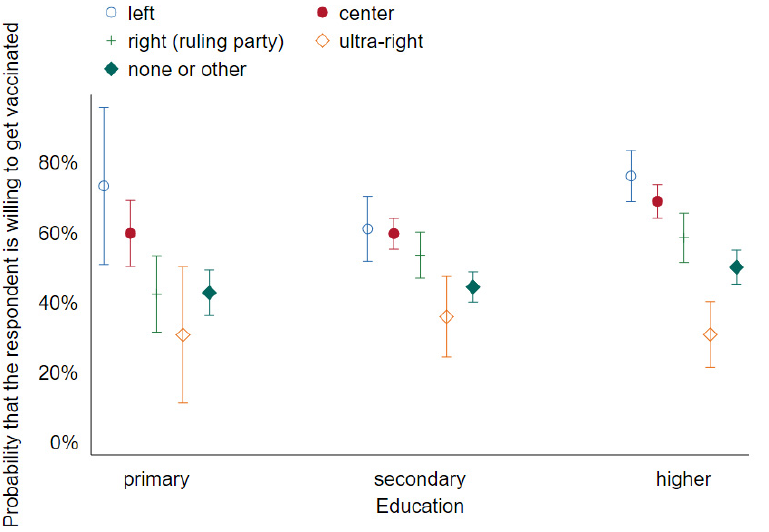
Figure 2. Predictive margins of education and voting preferences on vaccination decision with 95% CIs (Wave 1).